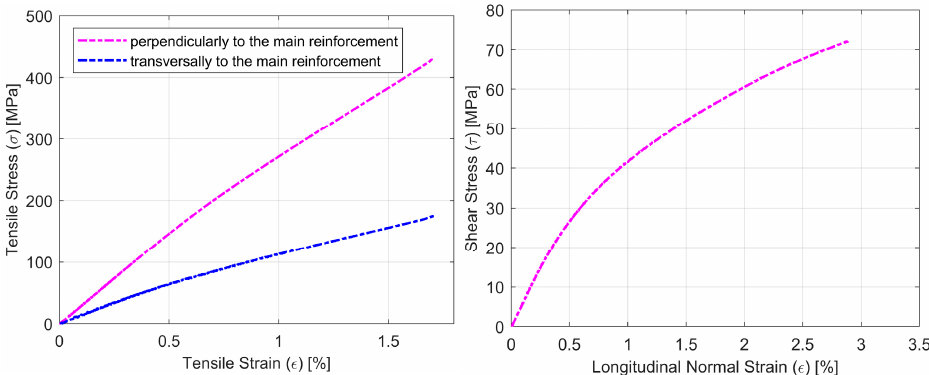
Figure 7. Representative curves for face laminate specimens at tension σ - ε ( left ) perpendicularly (1